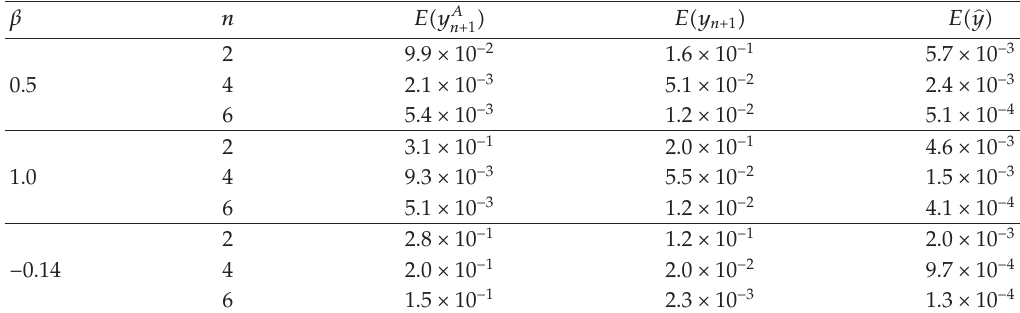
(cid:3) x (cid:4) , the presented solution y n (cid:5) (cid:3) x (cid:4) , 1 1